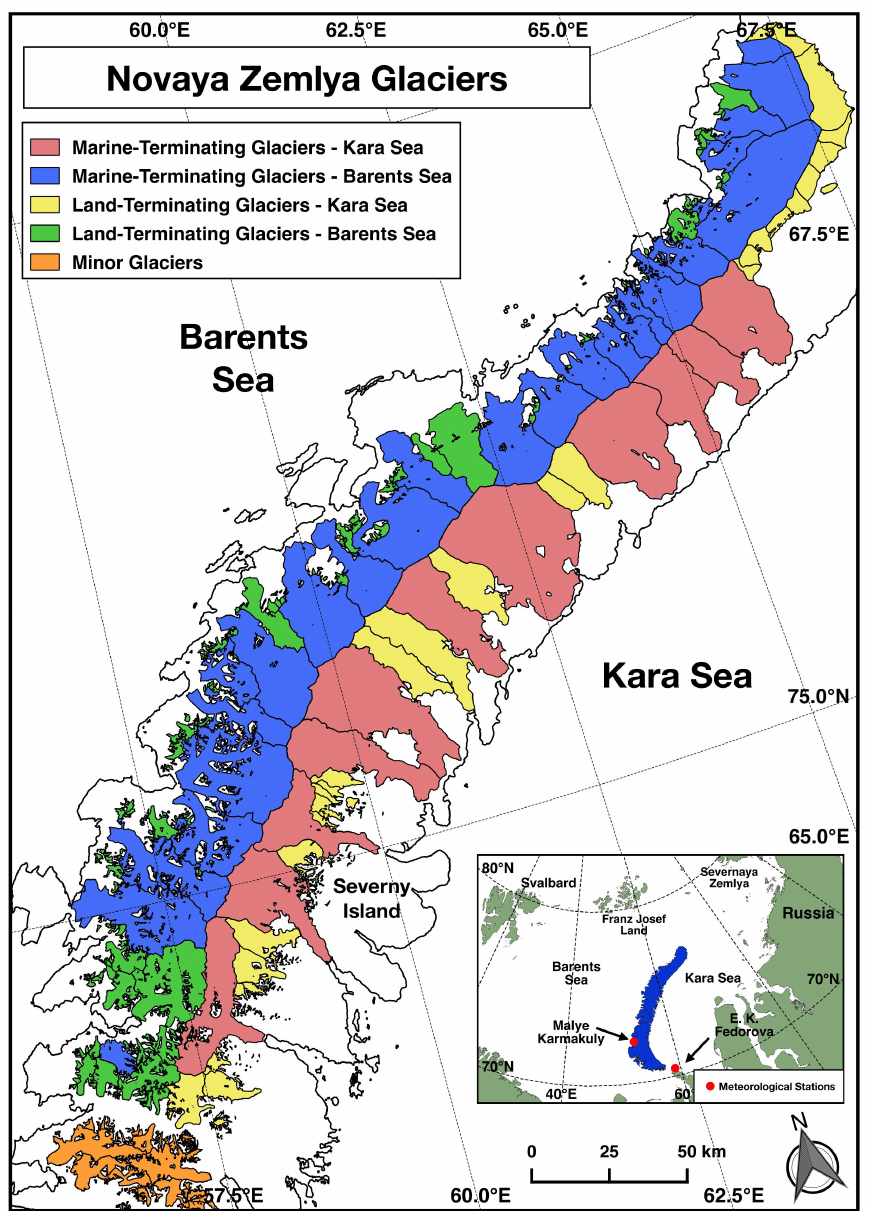
Figure 1. (a) Novaya Zemlya glaciers. Marine-terminating glaciers are red (Kara Sea) and blue (Barents Sea). Land-terminating glaciers are yellow (Kara Sea) and green (Barents Sea). Minor glaciers outside the Northern Ice Field are orange. Glaciers outlines are from Rastner et al. [24]. (b) Location of Novaya